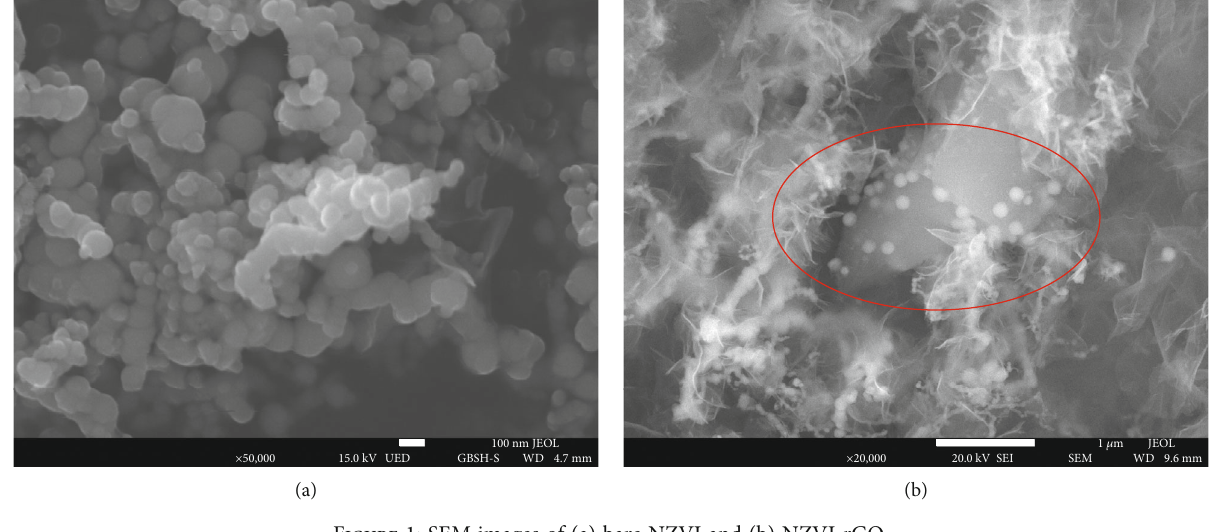
Figure 1: SEM images of (a) bare NZVI and (b) NZVI-rGO.